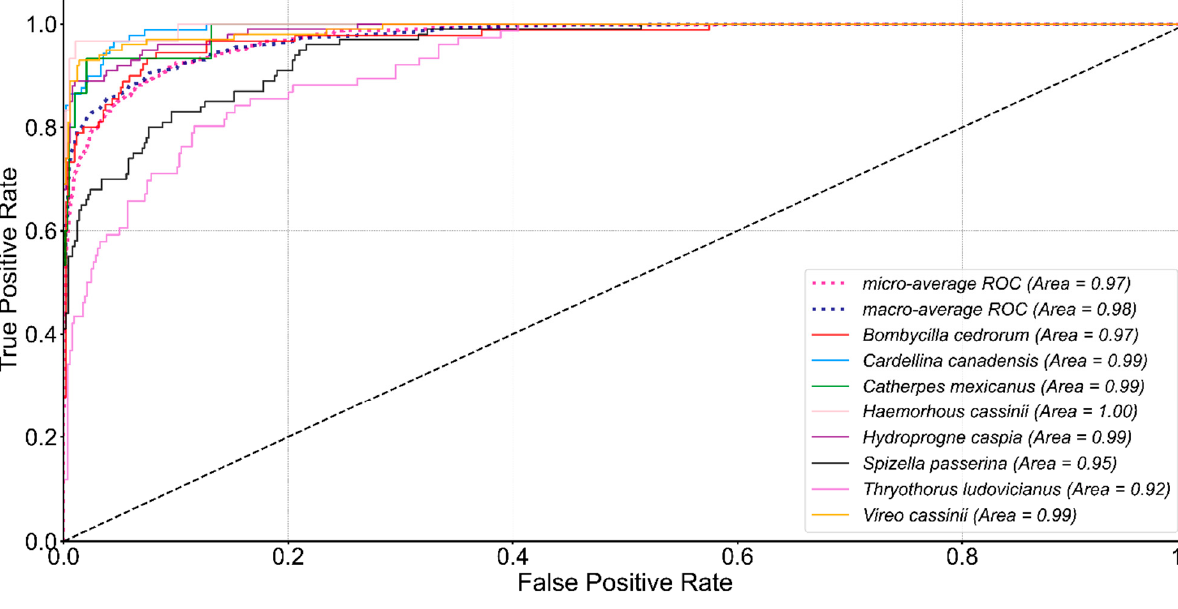
Figure 14. ROC Curves of the selected eight bird species. Micro and macro average ROC curves are dotted lines.